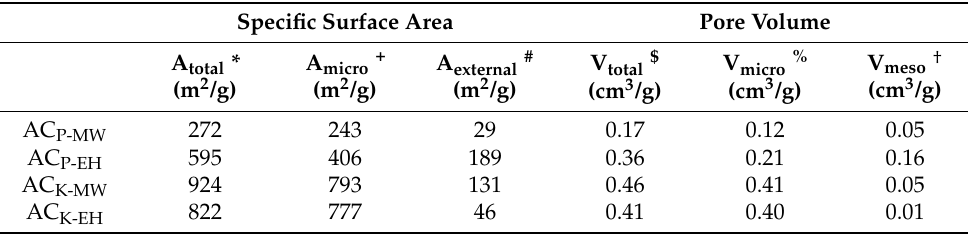
Table 1. Specific surface areas and pore volumes of prepared activated carbon.